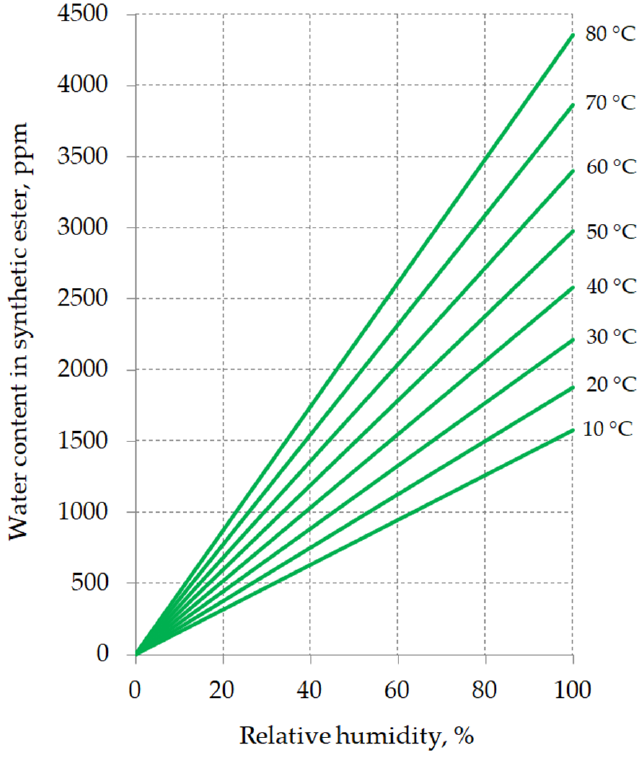
Figure 9. Water content in synthetic ester Midel 7131 of relative humidity, based on the data from [30].